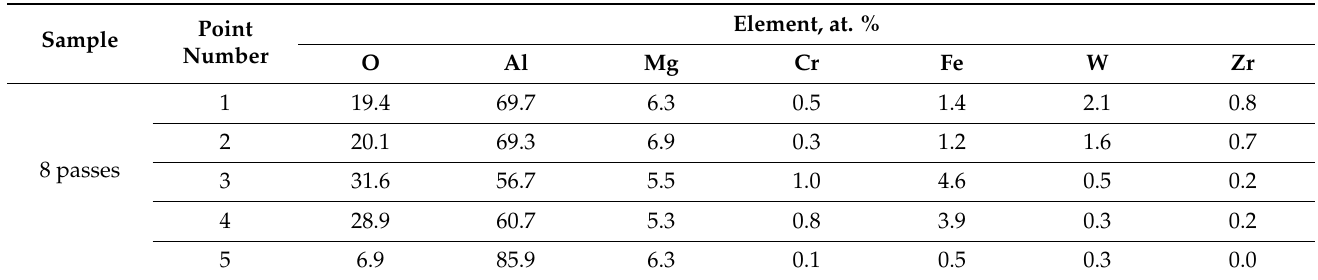
Table 5. Chemical composition (EDS) of the of microstructures formed by sliding below the worn surface of FSP-ed RPPs/AA5056 composites after 8 passes (Figure